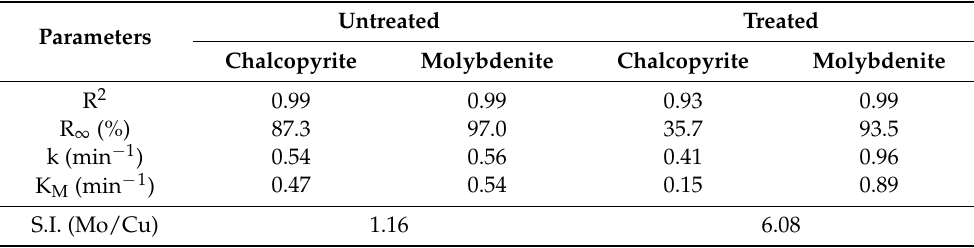
Table 1. Non-linear regression results for the first-order kinetic model fitting to the experimental data (Figure